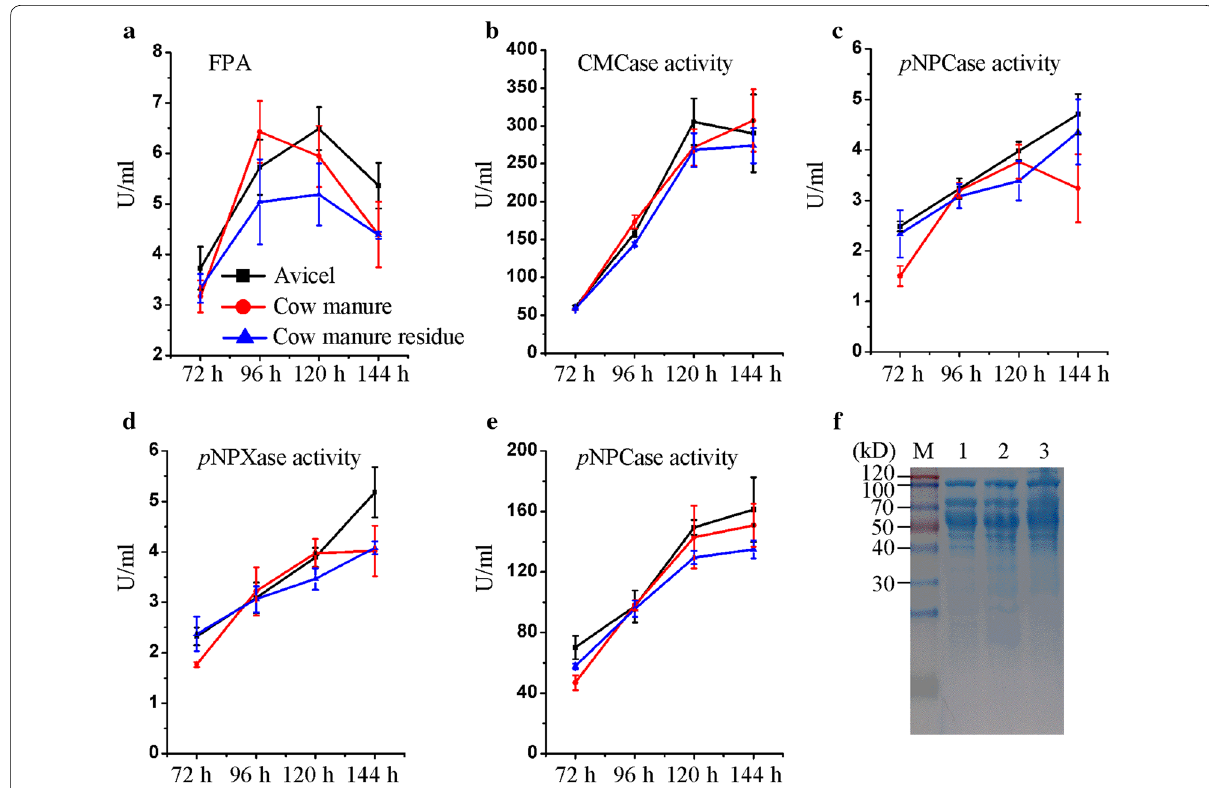
Fig. 2 Time course of cellulolytic enzyme activities by P. oxalicum . a – e Under original production medium (solid squares), cow manure (solid circles), anaerobically digested cow manure (triangles). Data presented are average of triplicate experiments; error bars indicate the standard deviations. f SDS-PAGE of proteins from unconcentrated culture supernatants of P. oxalicum C1-9 when cultured in cow manure medium (lane 2) and anaerobically digested cow manure medium (lane 3) as compared original production medium (lane 1) inducing cellulase expression for 96